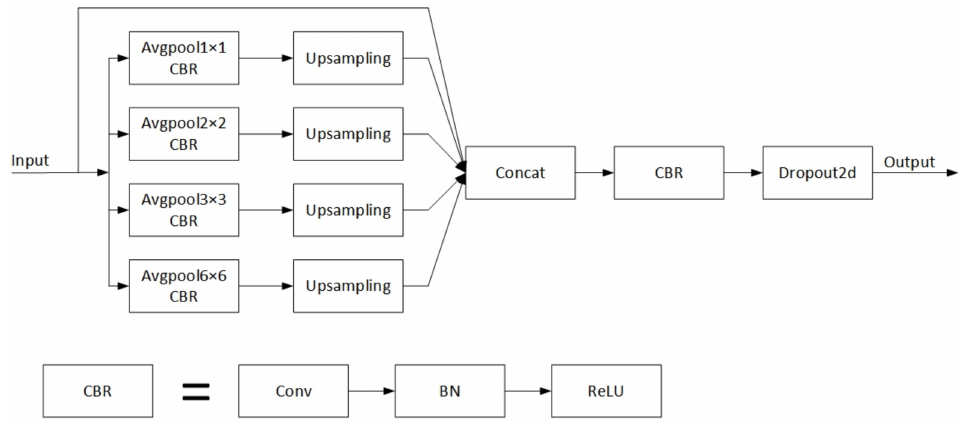
Figure 4. The pyramid pooling module’s architecture.